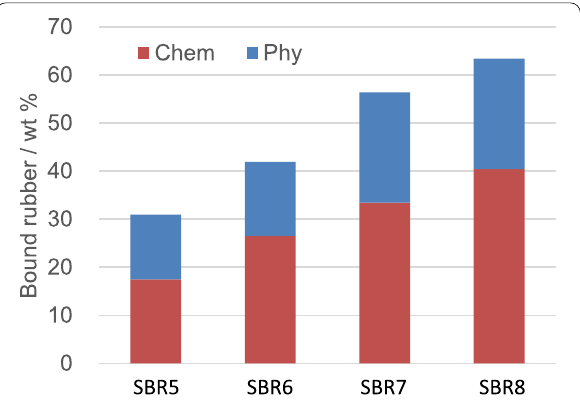
Fig. 16 Bound rubber contents of silica compounds with different SBRs (branched